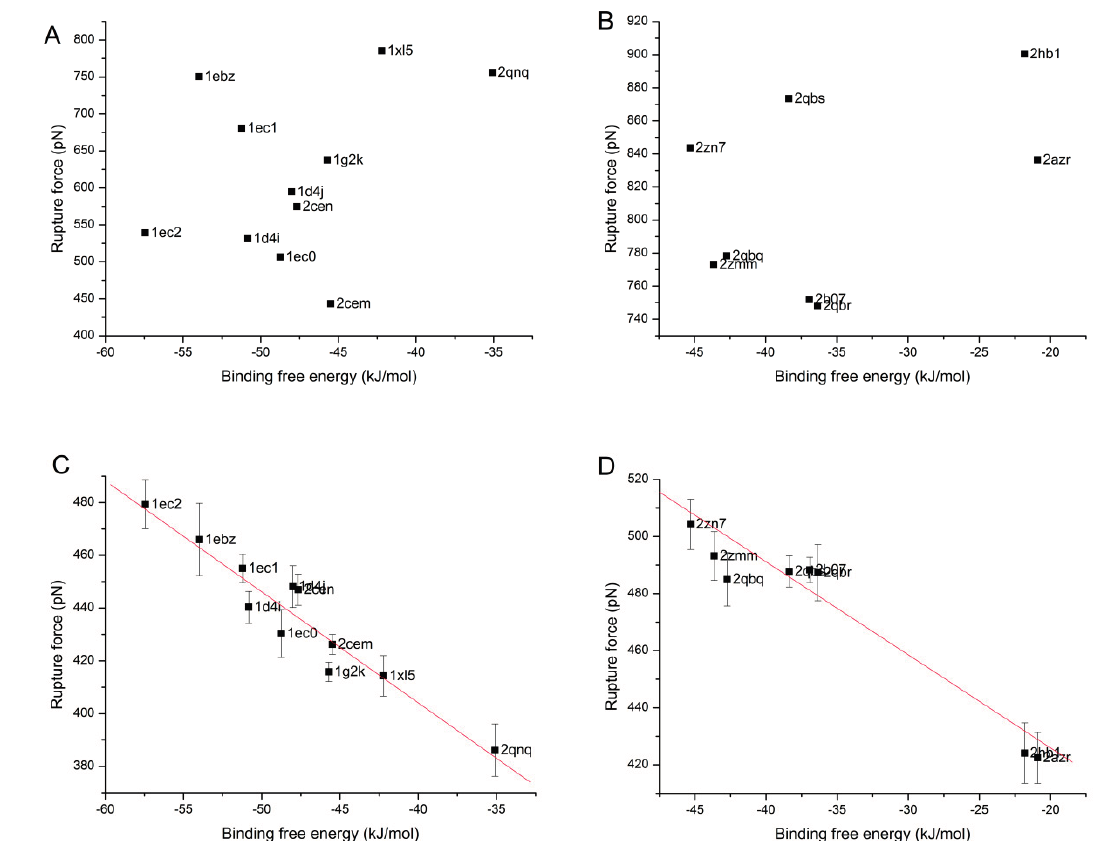
Figure 10. The relationship between the binding free energy and the rupture force obtained with C-SMD and SA-SMD of the complexes in the two protein families: ( A ) HIV-1 protease with C-SMD; ( B ) Tyrosine-protein phosphatase with C-SMD; ( C ) HIV-1 protease with SA-SMD and ( D ) Tyrosine-protein phosphatase with